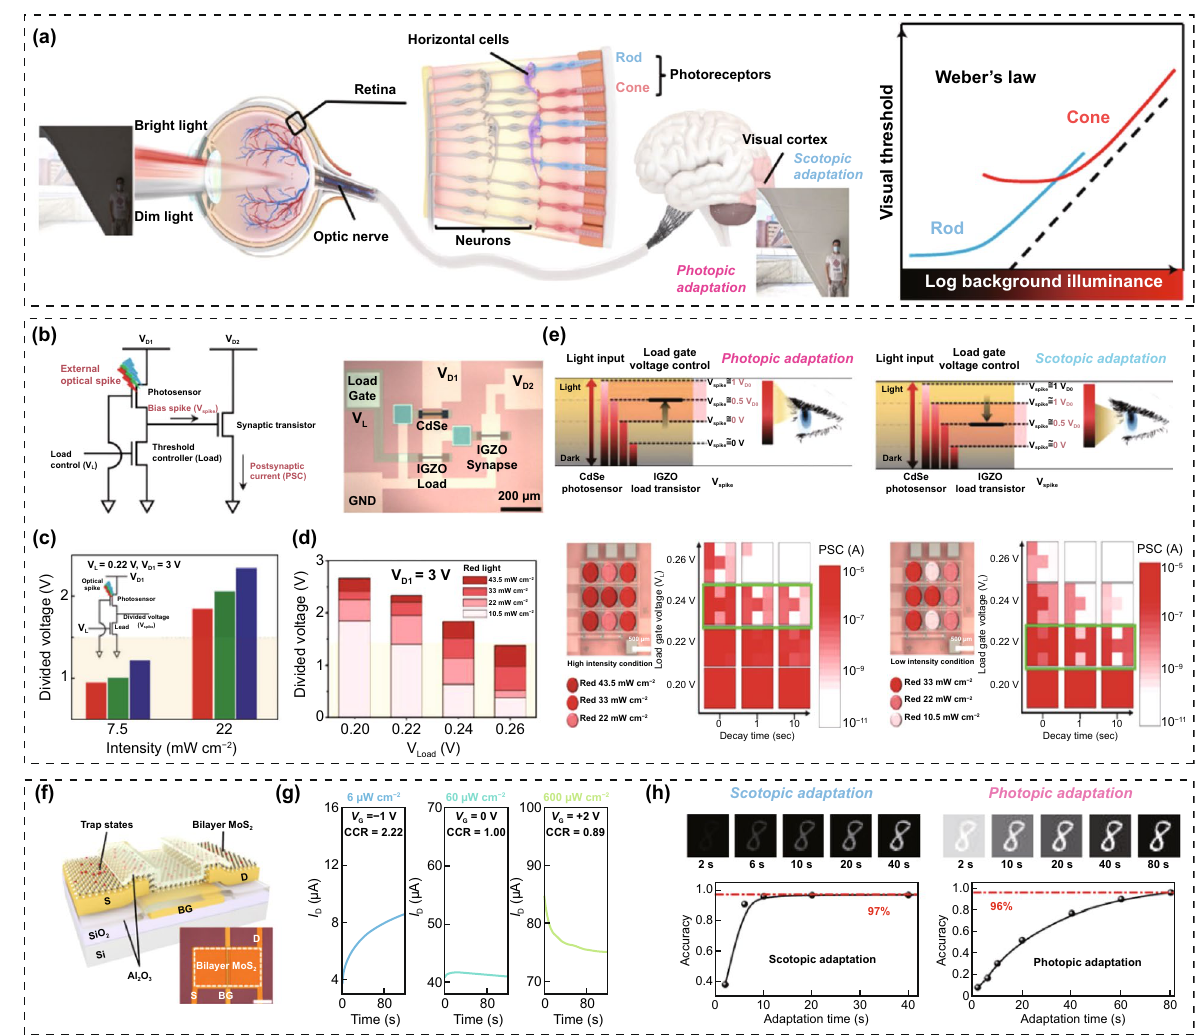
Fig. 12 Environment‑adaptable neuromorphic vision sensors. a Environment‑adaptable biological vision system consisting of rod and cone cells (Weber’s law, photopic and scotopic adaptation). b – e OSC‑type environment‑adaptable neuromorphic vision sensor: b circuit schematic, c light‑to‑bias conversion performance of photovoltaic divider, d the change of light‑adaptation mode through load gate voltage control, and e the image perception on photopic and scotopic adaptation modes. f – h OS‑type environment‑adaptable neuromorphic vision sensor: f device schematic, g the change of light‑adaptation mode through load gate voltage control, and h image perception on photopic and scotopic adapta‑ tion modes. a , f – h Reproduced with permission from Ref. [95]. Copyright @ 2022, Springer Nature. b – e Reproduced with permission from Ref. [96]. Copyright @ 2019,